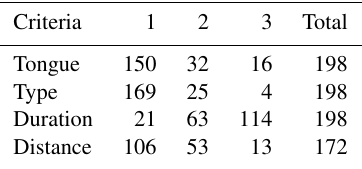
Table 4. Results of the surging classification (counting per class). Glaciers with incomplete active surge phases (starting before 1988 or ending after 2018 and marked with a “0” for the distance crite- rion) are not listed here. See Sect. 4.2 for the meaning of classes 1, 2 and